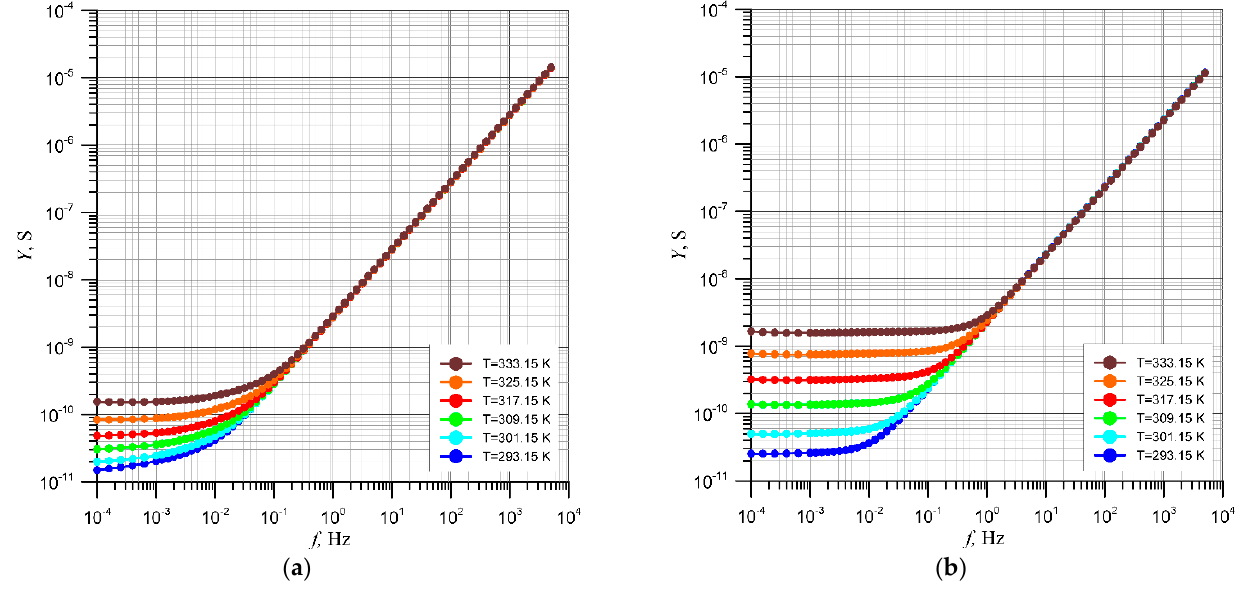
Figure 2. Frequency dependencies of the admittance of mineral insulating oil with a moisture content of 5 ppm—( a ) and moistened mineral oil—( b ) at temperatures from 293.15 K to 333.15 K in steps of 8